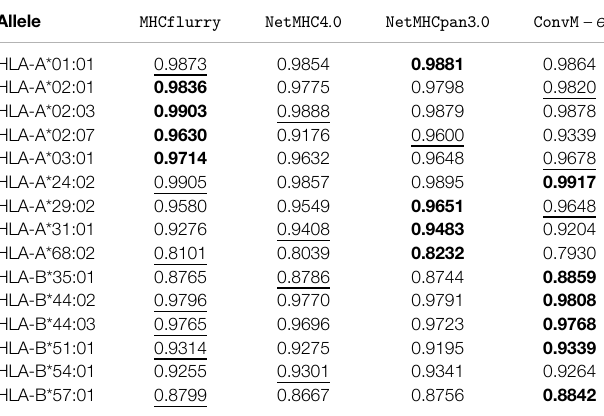
TABLE 8 | Performance comparison over mass spectrometry dataset in AUC .